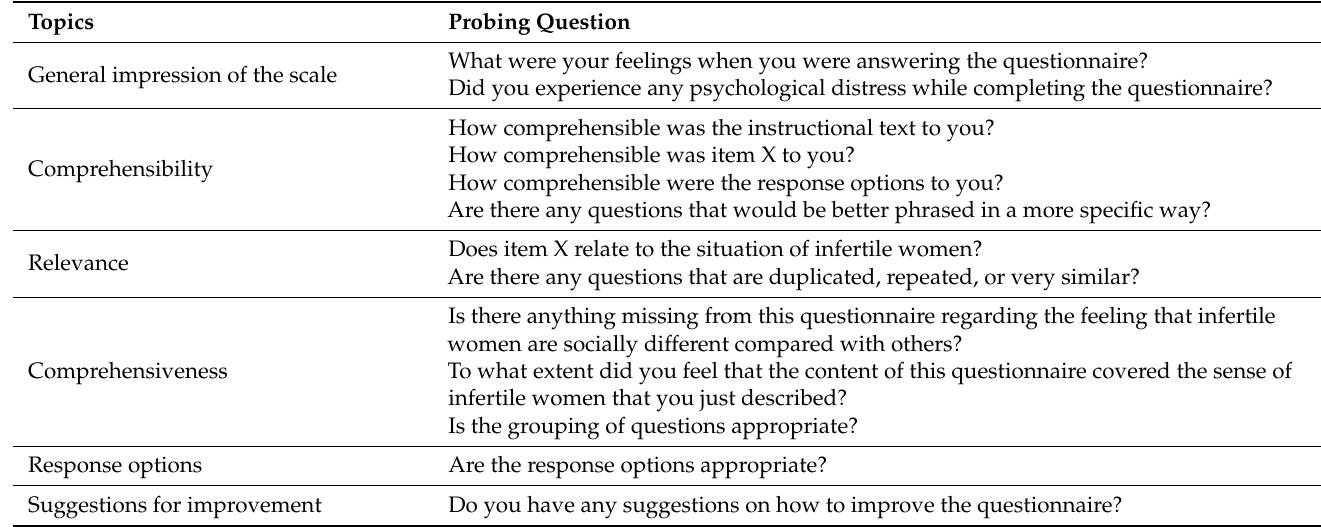
Table A3. Semistructured cognitive debriefing interview guide.